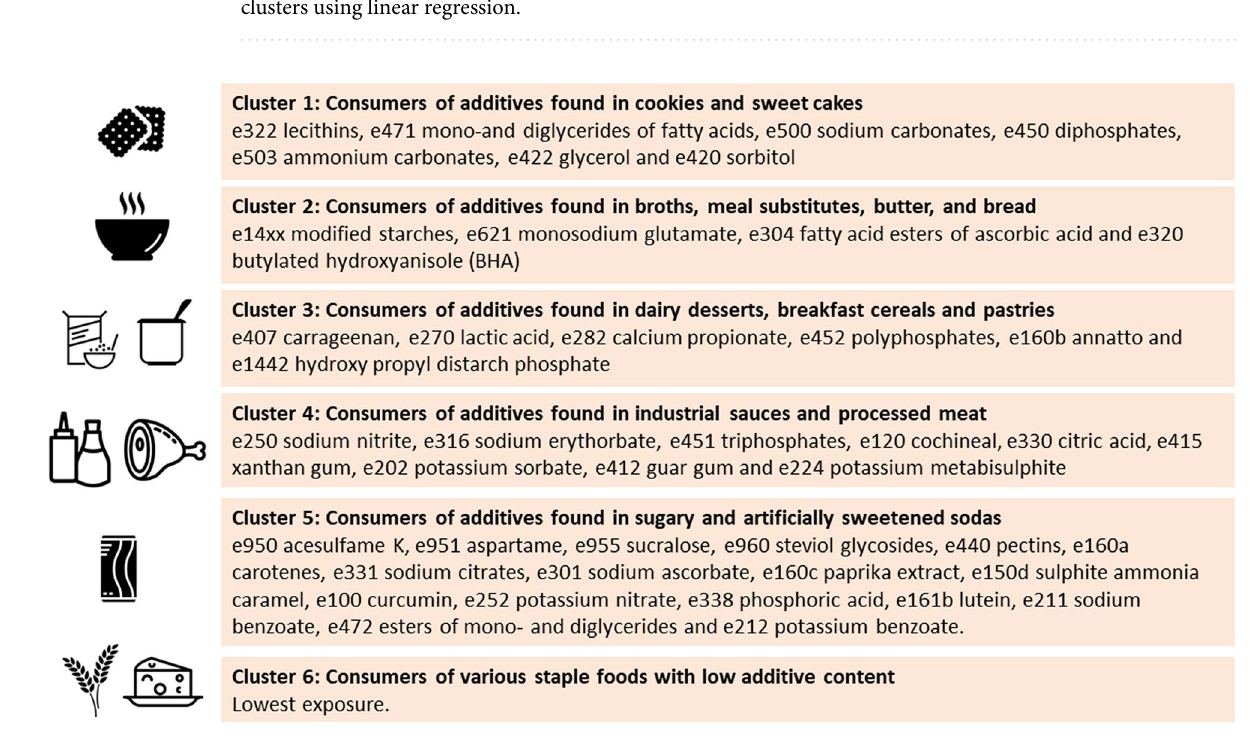
Figure 3. Synthesis of cluster intakes in food groups and additives, NutriNet-Santé cohort, France, 2009–2020 (N =